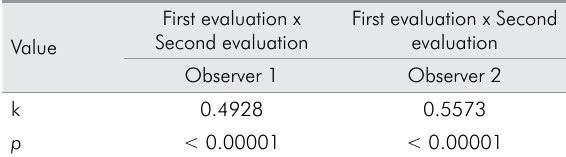
Table 2. Intraobserver